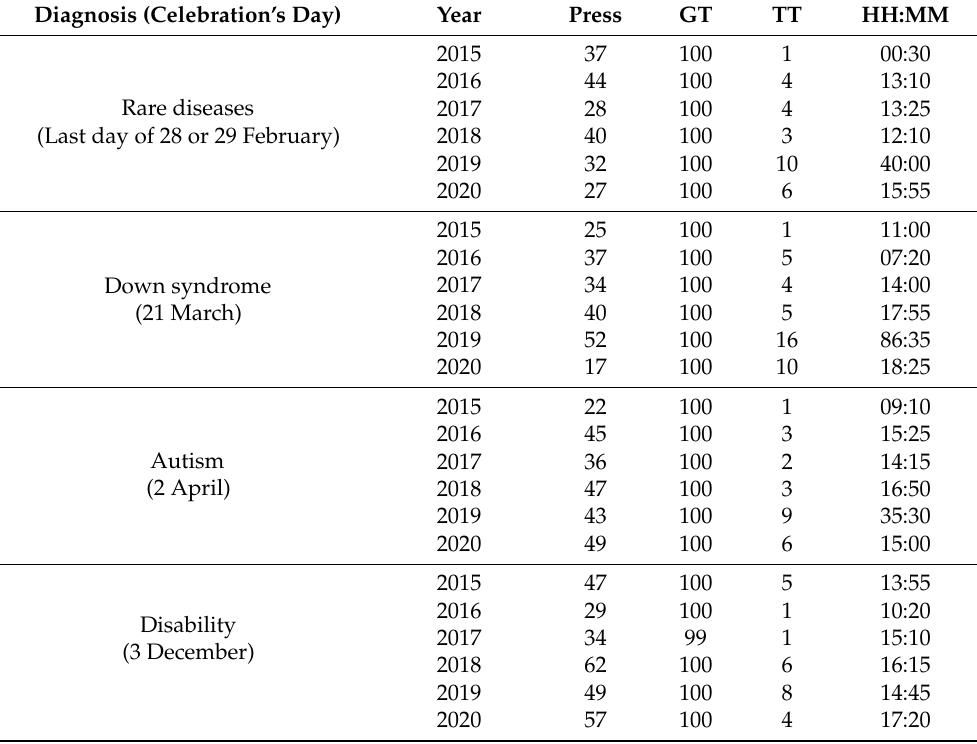
Table 4. Campaigns with high impact 1